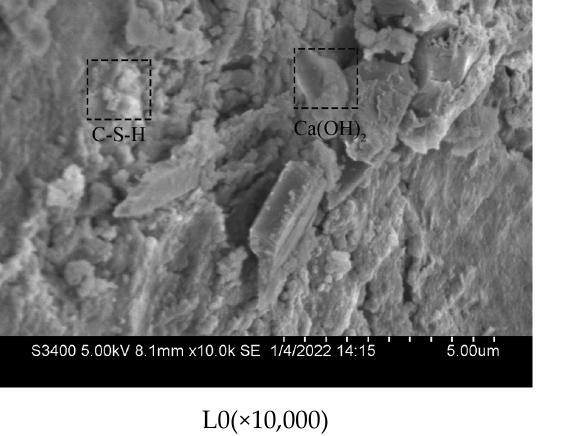
Figure 14. XRD analysis of sulfate attack products.